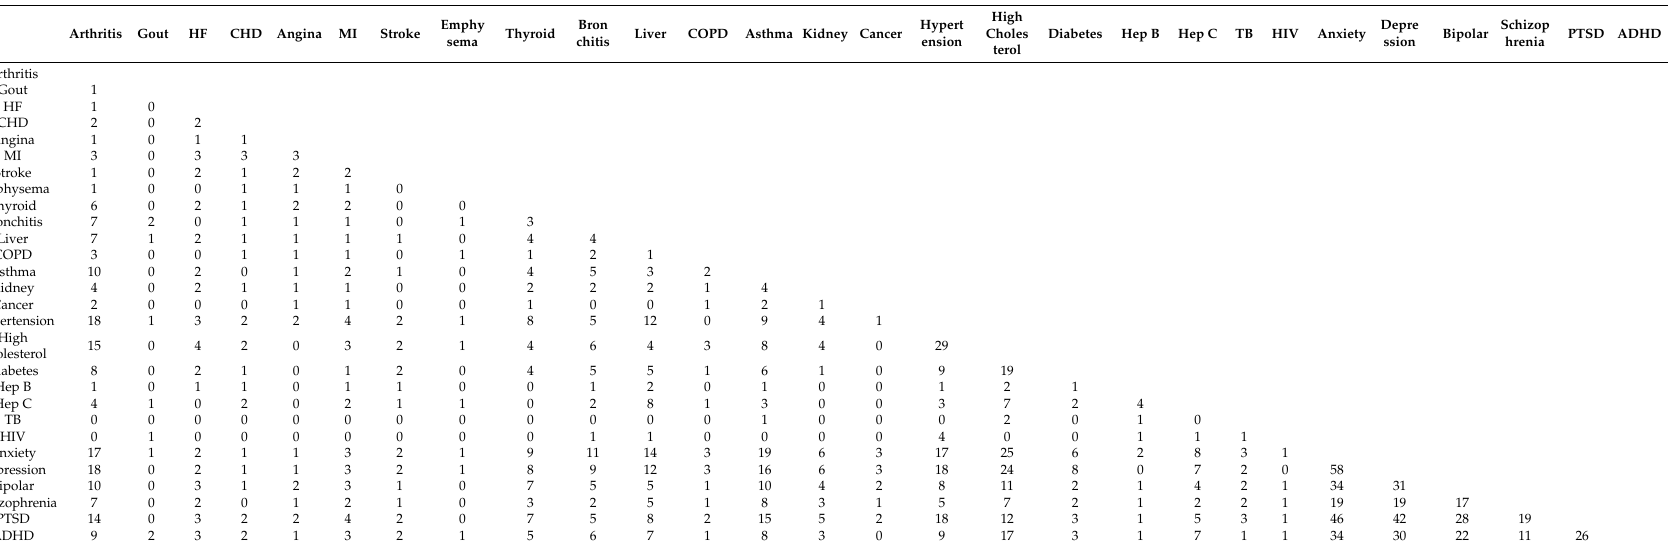
Table 4. Co-Morbidity Matrix Showing Dyadic Relationships with Self-Reported Health Conditions for incarcerated individuals. Arthritis Gout HF CHD Angina MI Stroke Emphy